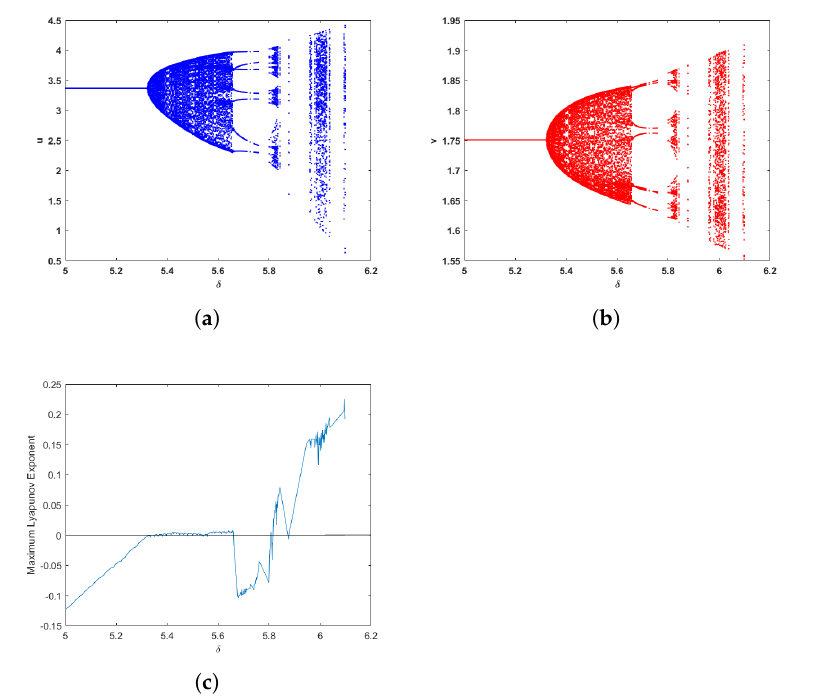
Figure 2. ( a , b ) Bifurcation diagram corresponding to u and v in system (2) with δ ∈ [5, 6.2], r 1 = 0.8, r 2 = 0.8, a = 0.4, b = 0.2, c = 2, d = 0.1, k = 5, h 1 = 0, h 2 = 0.1, the initial value is ( u , v ) = (3, 2). ( c ) Maximum Lyapunov exponents related to ( a